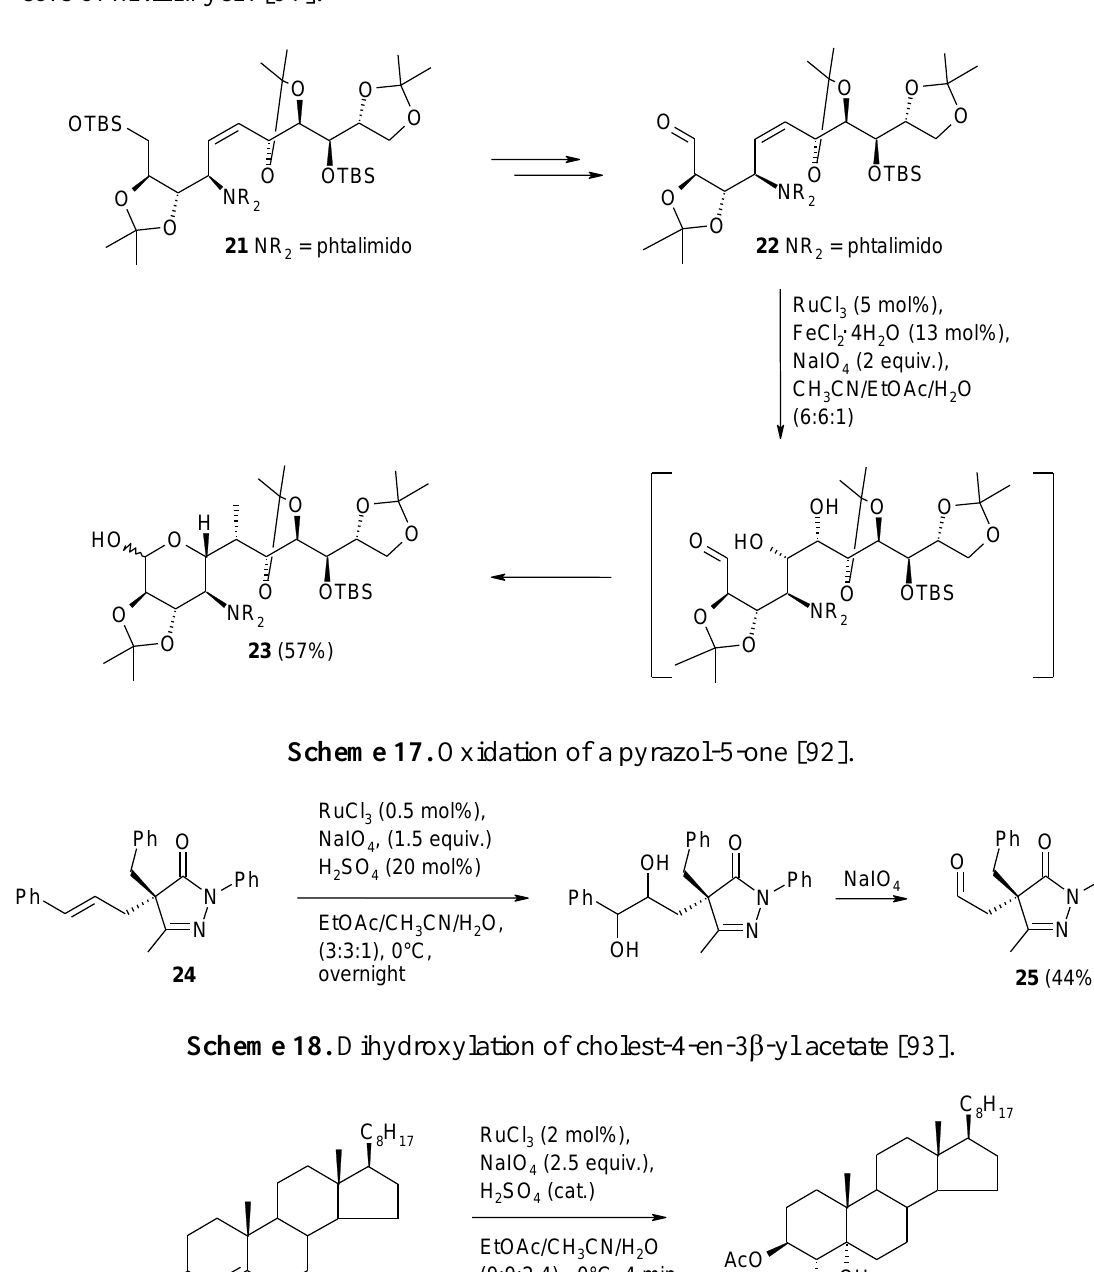
Scheme 16. A highly diastereoselective dihydroxylation step during the synthesis of the core of hikizimycin [91].